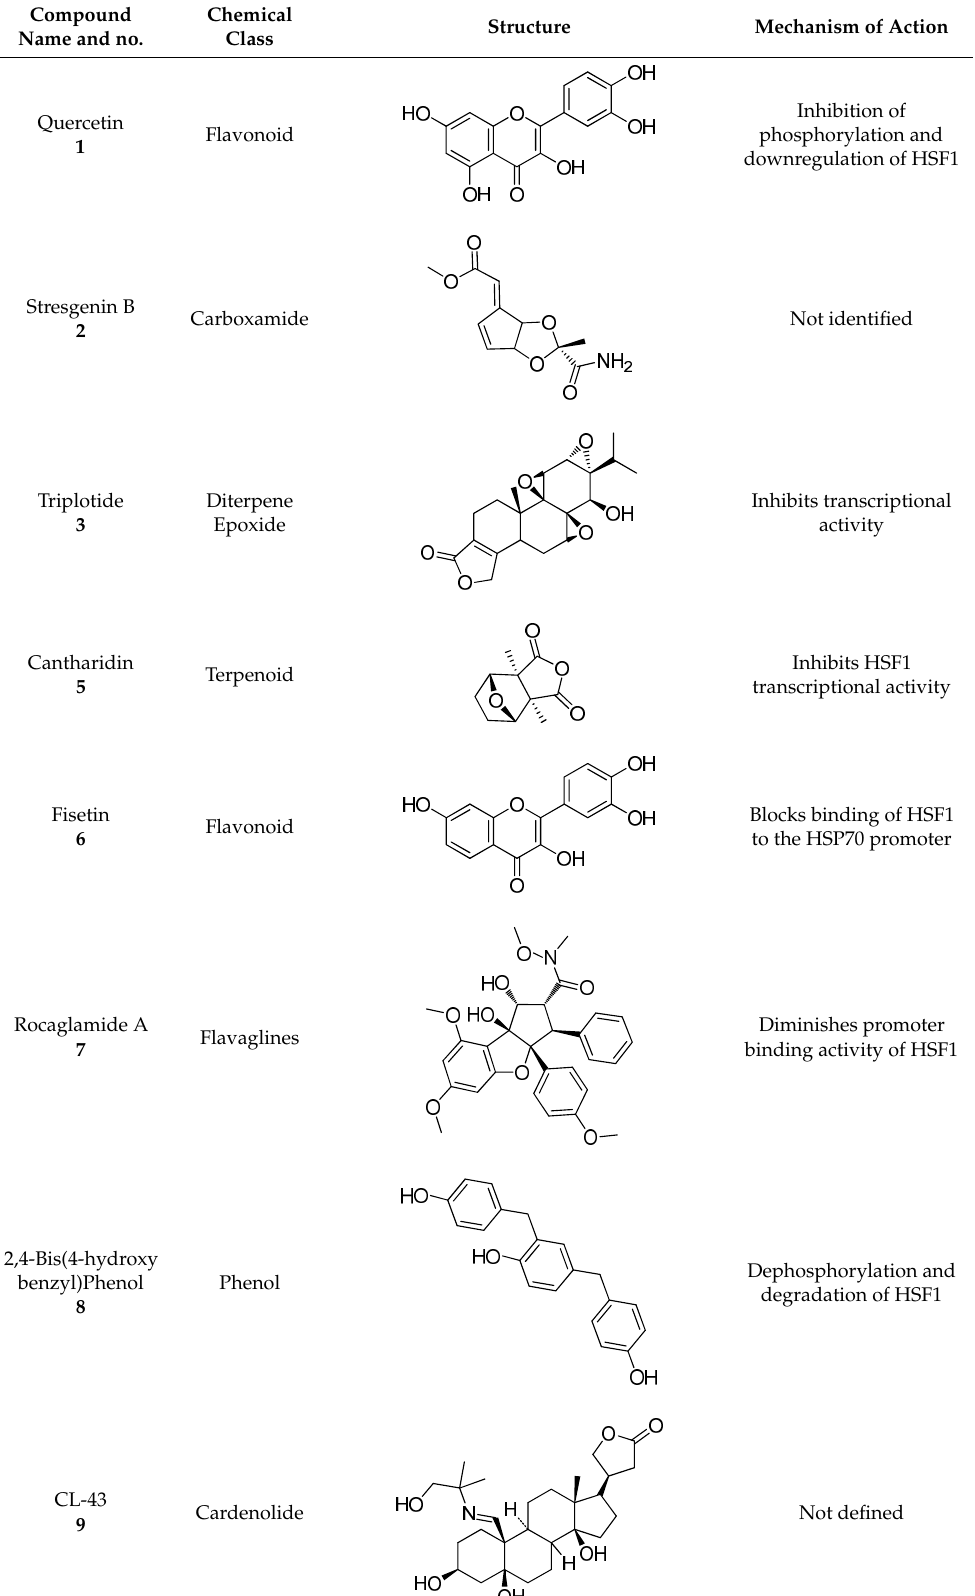
Table 2. List of HSF1 inhibitors of natural origin.